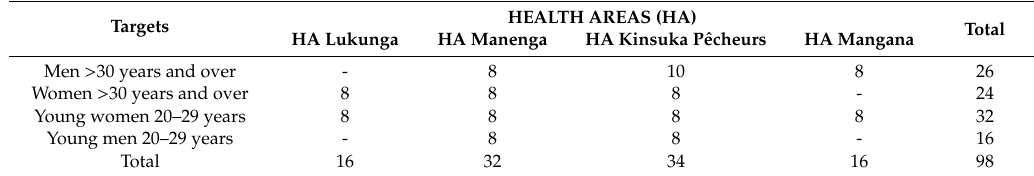
Table 1. Distribution of sample size by health area and by target for the focus group. Targets